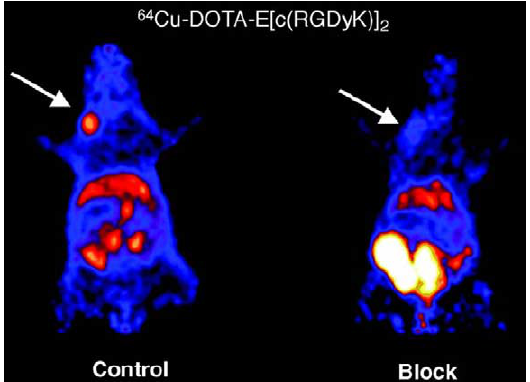
Fig. 2. MicroPET images of MDA-MB-435 breast tumour bear- ing athymic nude mice 2 h after administration of 400 µ Ci of 64 Cu-DOTA-E[c(RGDyK)] 2 , with (left) and without (right) a co-injected blocking dose of c(RGDyK), a known α v β 3 integrin an- tagonist. The ability to inhibit tumour uptake with a blocking dose of c(RGDyK) demonstrates receptor-specific tumour activity accumu- lation of this tracer. Reprinted from Molecular Imaging and Biology , 6 (5), 350–359, Chen X., Liu S., Hou Y. et al., MicroPET imaging of breast cancer α v β 3 -integrin expression with 64 Cu-labelled dimeric RGD peptides. Copyright 2004, with permission from Elsevier